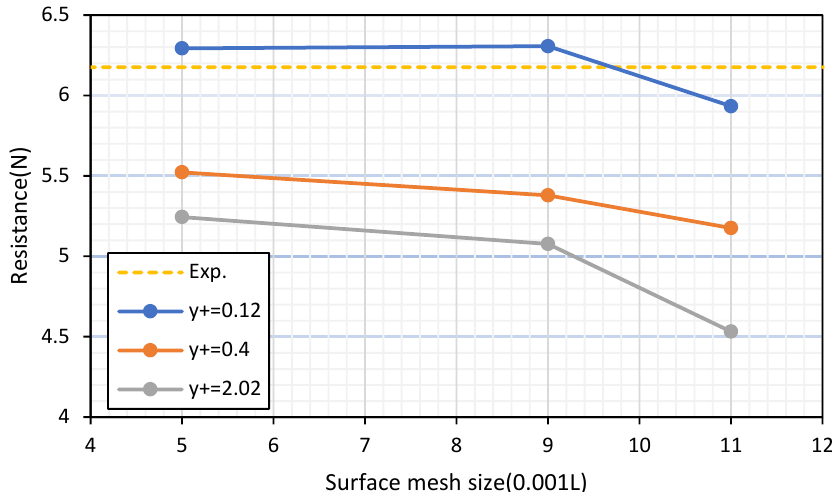
Figure 7. Calculated resistance in mesh independence analysis.